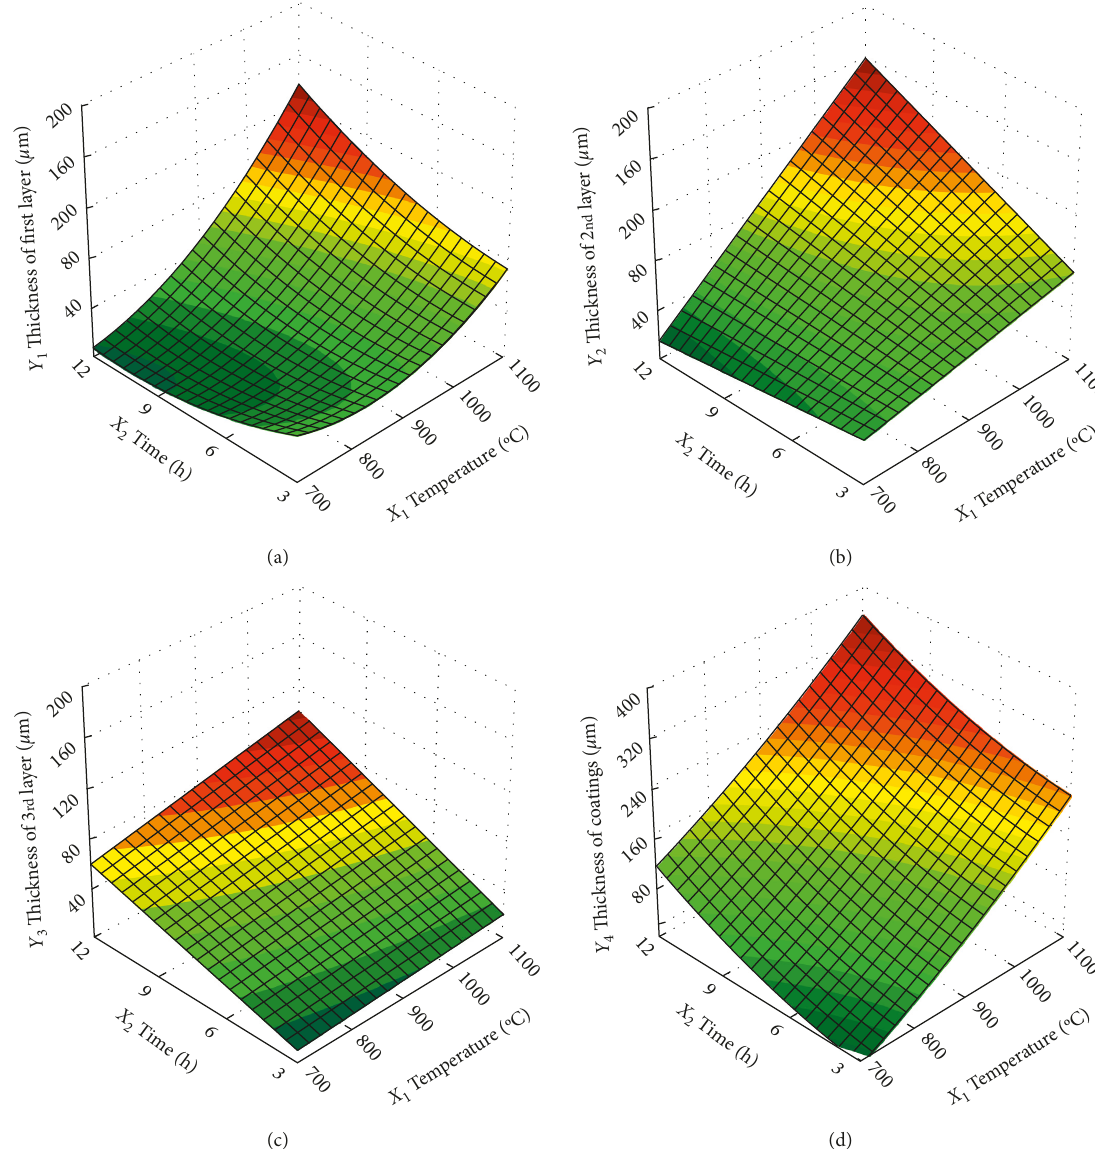
Figure 4: Graph of the correlation between the technological parameters and the thickness of (a) first layer, (b) second layer, (c) third layer, and (d)